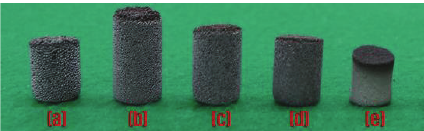
Figure 6: Photographs of bulk samples sintered at 1150 ∘ C for 80 min: (a) sample A (+50 mesh), (b) sample B (50 ∼ 70 mesh), (c) sample C